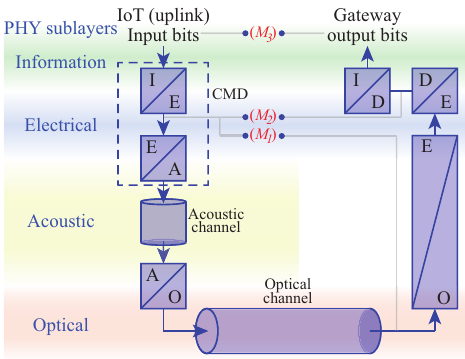
Figure 3. Flowchart of the physical connectivity (PHY) sublayer communication. I/E: information-to-electrical, E/A: electrical-to-acoustic, A/O: acoustic-to-optical, O/E: optical-to-electrical, E/D: electrical-to-digital, and D/I: digital-to-information conversions. M 1 , M 2 , and M 3 , represent the measurement points used for the system